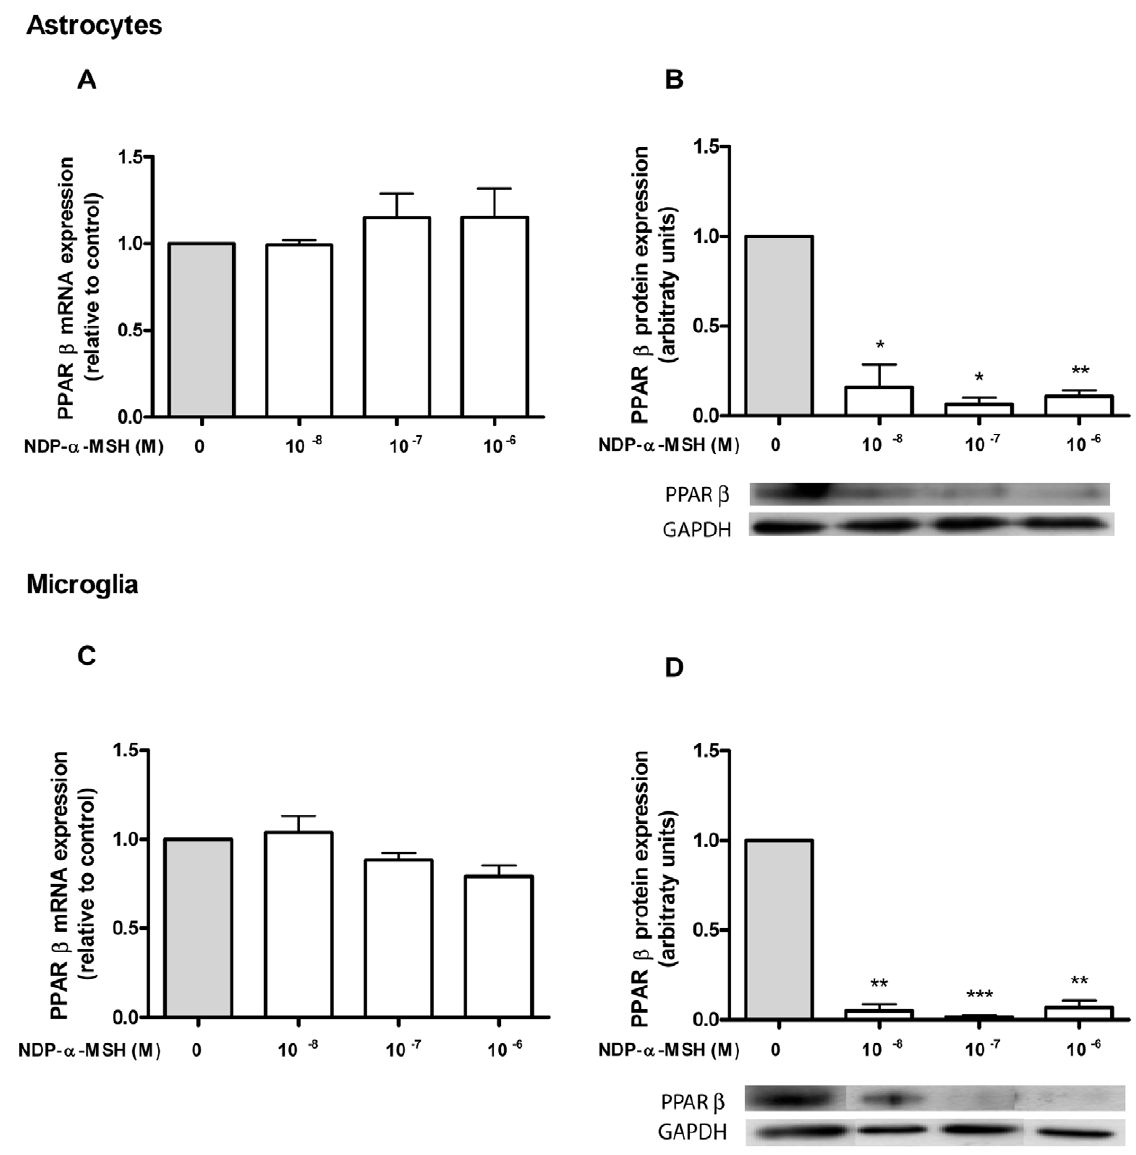
Figure 3. PPAR- b expression in rat astrocytes and microglia. (A and C) Gene expression was studied by real time quantitative RT-PCR as described in Materials and Methods. No significant change in PPAR- b mRNA levels was detected after 24 h of incubation with NDP- a -MSH in both cell types. (B and D) Protein expression of PPAR- b was assessed by western blot after 24 h of treatment. NDP- a -MSH markedly decreased PPAR- b protein levels in both cell types. Data were analyzed by one sample t Test and are expressed as mean 6 SEM. *** p , 0.001, ** p , 0.01, * p , 0.05 vs. control group.